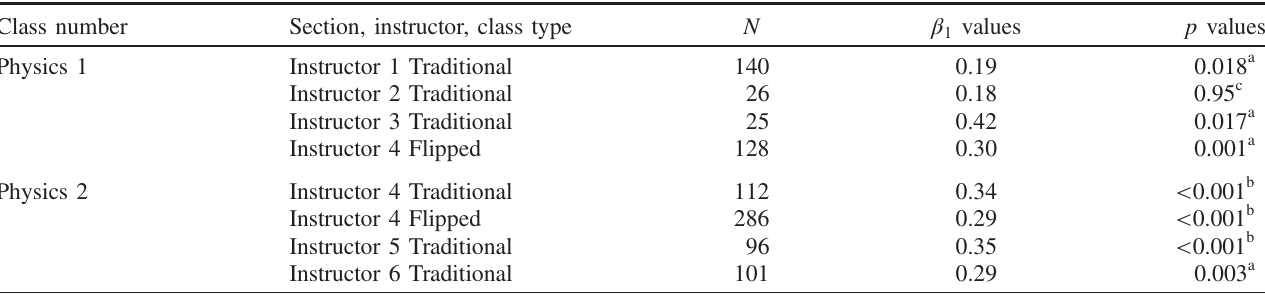
TABLE X. For different instructors and class types in physics 1 and physics 2 courses, number of students ( N ), gender standardized coefficient ( β 1 ), and p values are given.